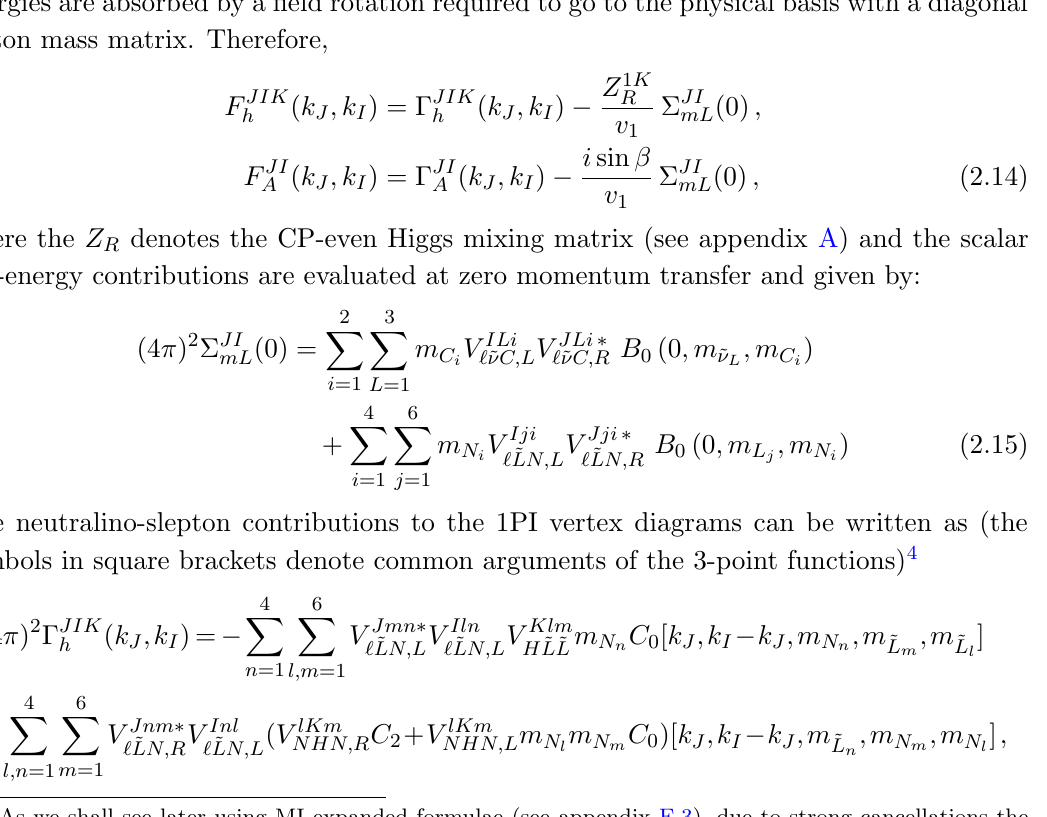
Figure 3 . Slepton-neutralino diagrams contributing to the H K the MSSM (the mirror-re(cid:13)ected self-energy diagram is